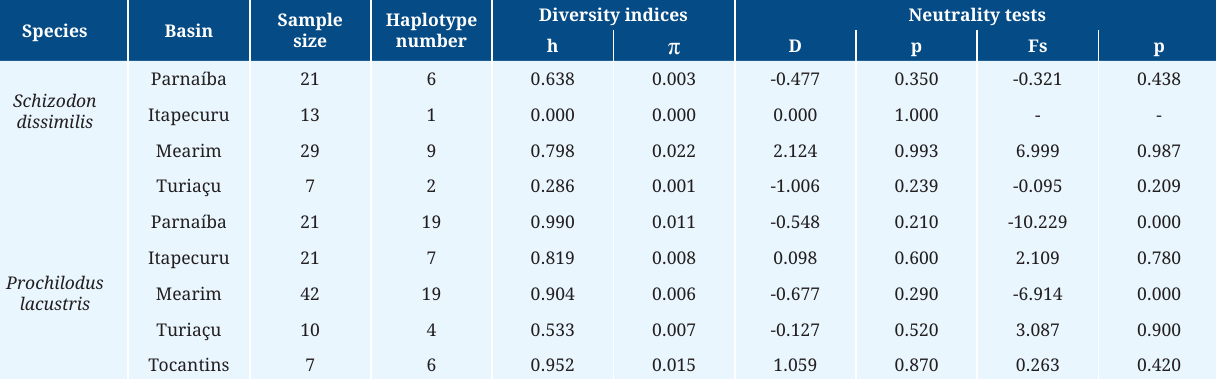
TABLE 2 | Genetic diversity indices and neutrality test for samples of Schizodon dissimilis and Prochilodus lacustris analyzed in this study. h = haplotype diversity; π = nucleotide diversity; D = Tajima test; Fs = Fu test; p = significance probability. p for Fs = 0.02.